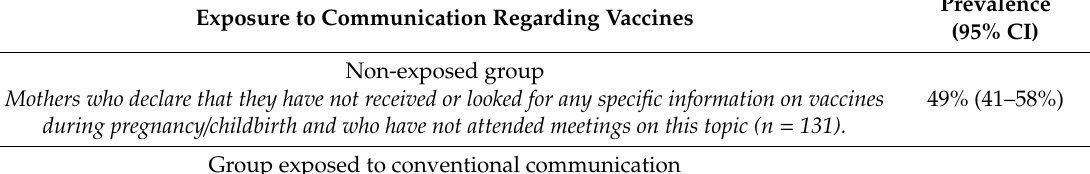
Table 2. Di ff erent exposures to communication regarding vaccines: prevalence of mothers in each subgroup. Exposure to Communication Regarding Vaccines